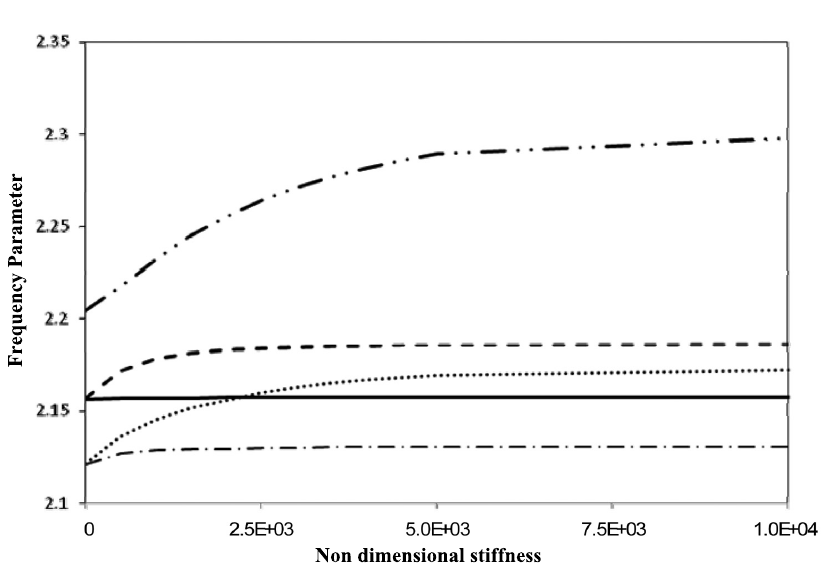
Fig. 3. Variation in the frequency parameters of selected modes with varying normalized point support stiffness at the outer edge of an annular disk clamped at the inner edge ( v = 0.3, β = 0.2), (1,1)E, (1,1)O, (0,3)O, (0,3)E,